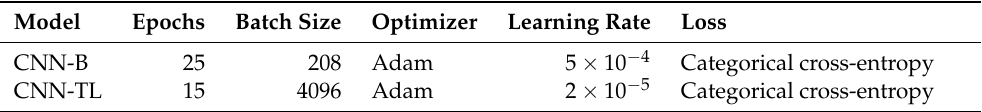
Table 9. TL model training parameters